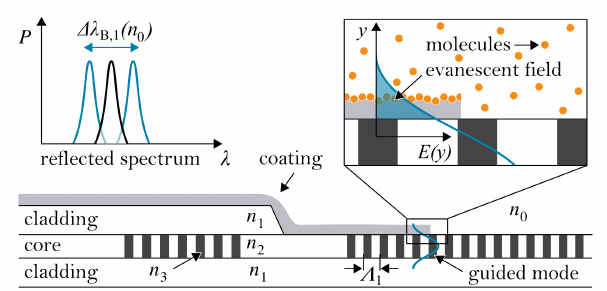
Figure 1. Cross-section of the planar Bragg grating showing two BGs located in the waveguide core of which one is uncovered by the upper cladding. The close-up depicts the evanescent field interaction of the guided mode with the surrounding medium and the principle of surface functionalization. The graph shows the reflected Bragg wavelength’s dependency on the surrounding medium’s refractive